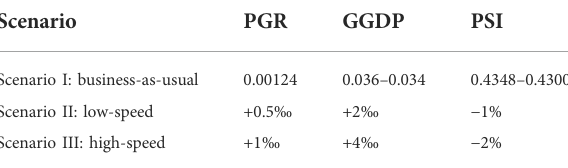
TABLE 4 Scenario setting of coal demand system in Shanxi